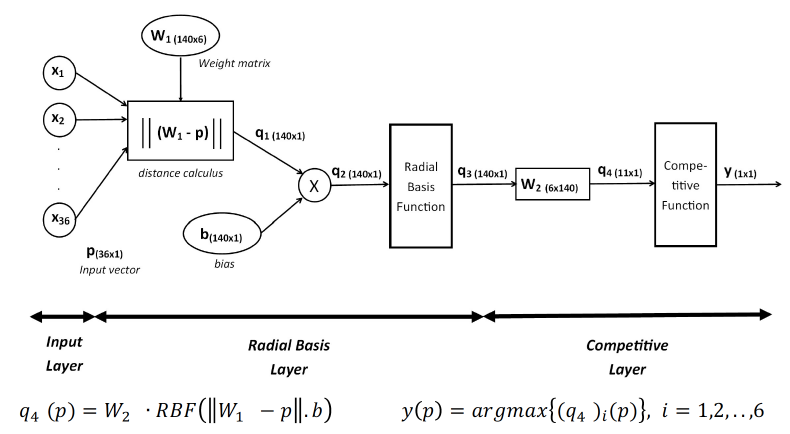
Figure 1. Probabilistic Neural Network architecture, depicting 140 neurons in the radial basis layer, the weights W1 and W2, the bias b, for 36 inputs (the 2D coordinates of the 18 nodes human body model) and the output class (the 6 possible classes of human poses).